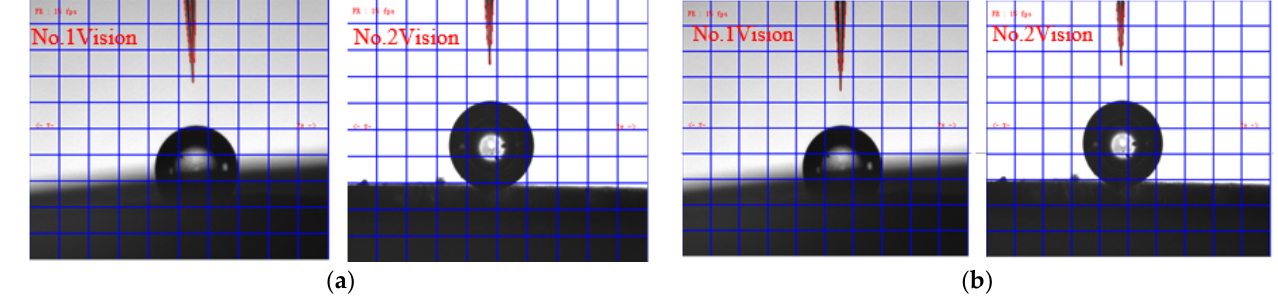
Figure 10. Image of attitude fine alignment: ( a ) images before attitude alignment; ( b ) images after attitude alignment.